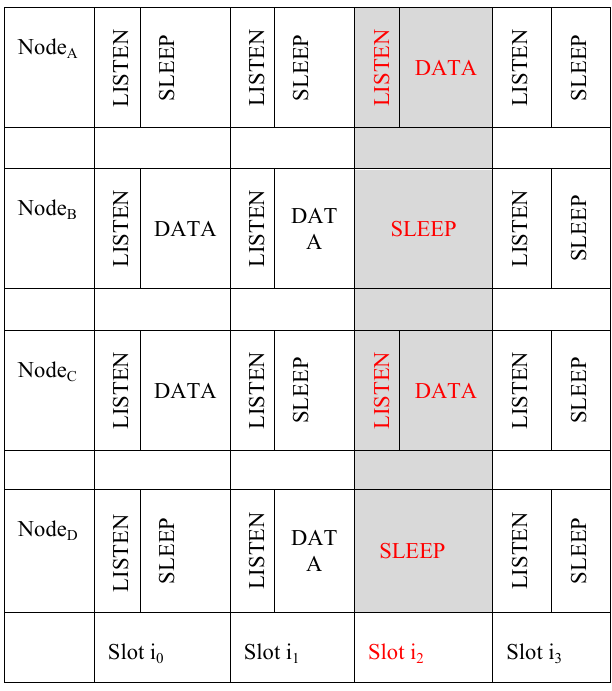
Fig. 7 Sensor nodes energy saving scheme timing diagram of I-XLP (the red portion is rendezvous slot of our protocol and remaining slots are like other